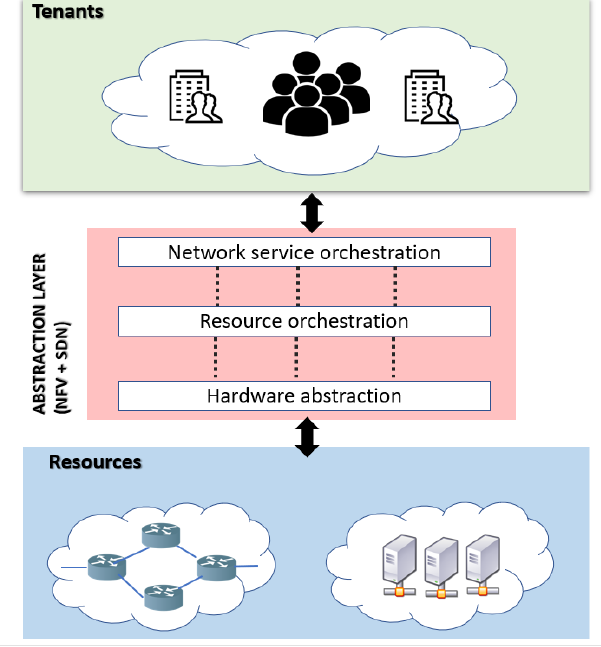
Figure 3. SDN enabled NFV: Multi-layer for unifying computer and network